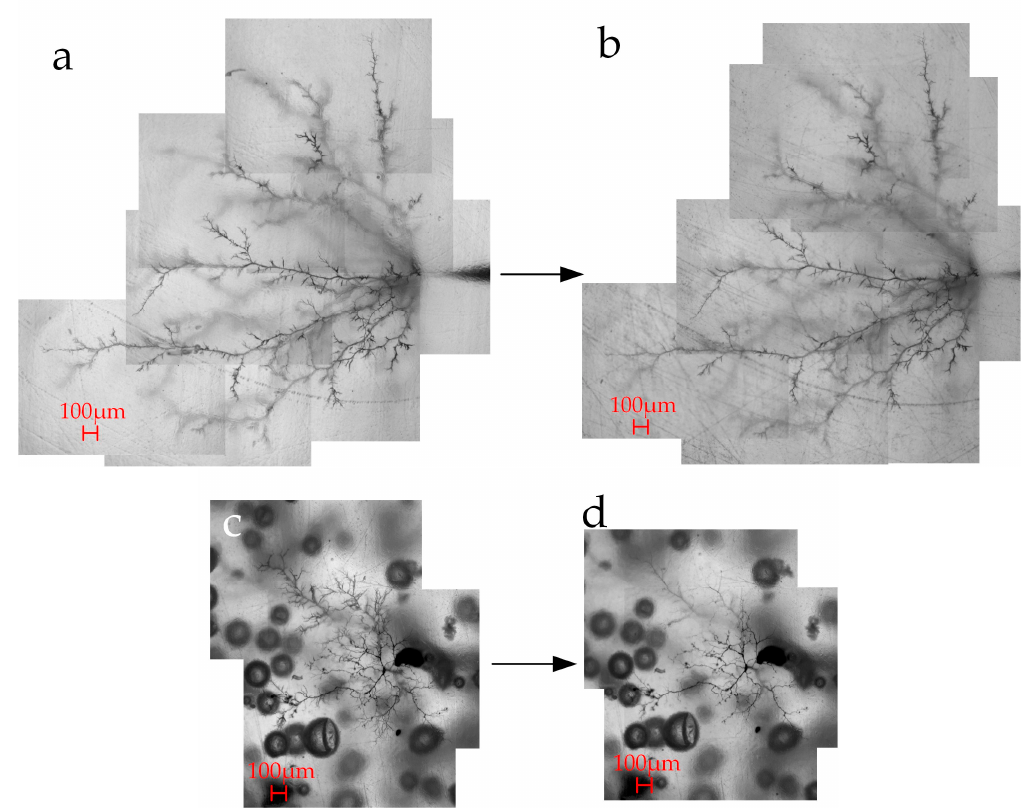
Figure 7. Morphology of the electrical tree. ( a ) Unheated pure epoxy resin. ( b ) Heated pure epoxy resin. ( c ) Unheated composite. ( d ) Heated composite.